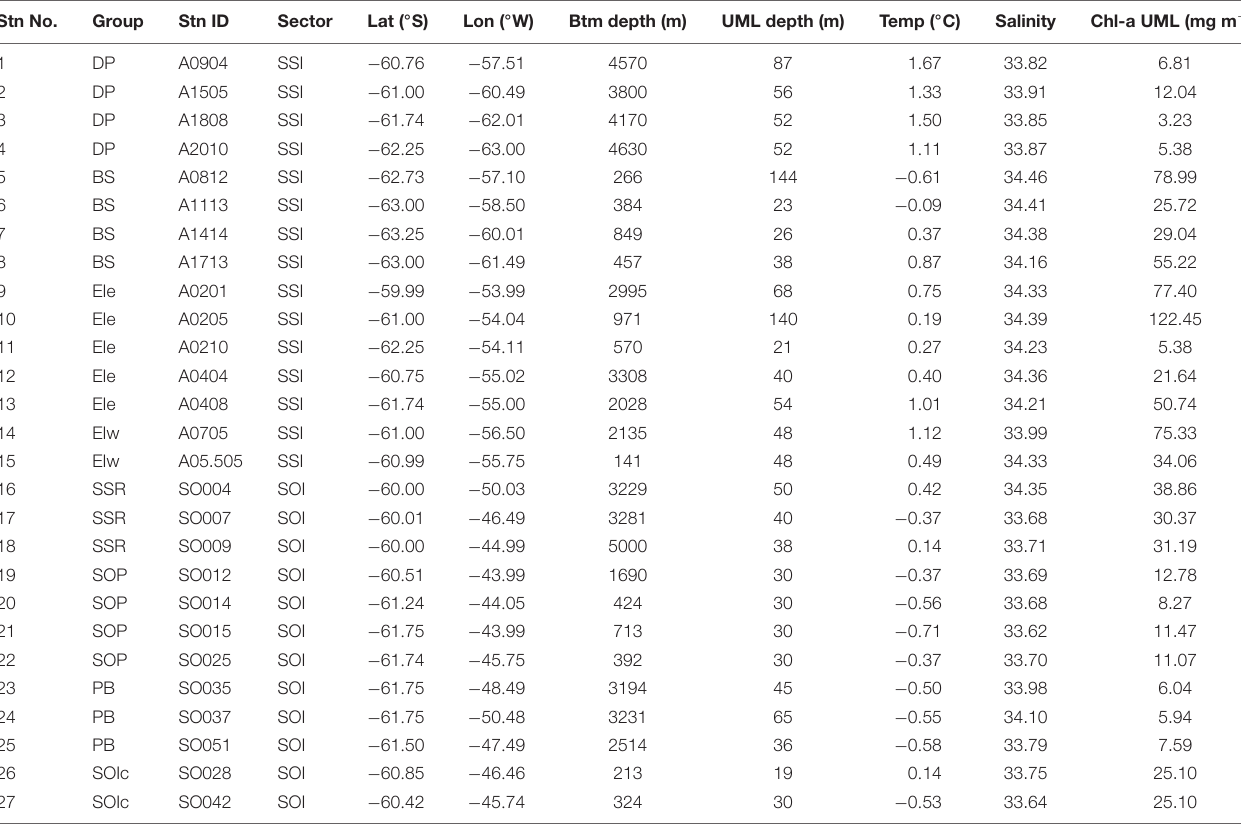
TABLE 1 | Main bio-oceanographic parameters for the 27 Fe stations. Stn